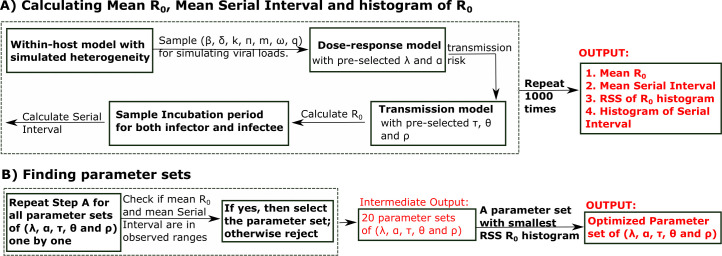
Mathematical model workflow.